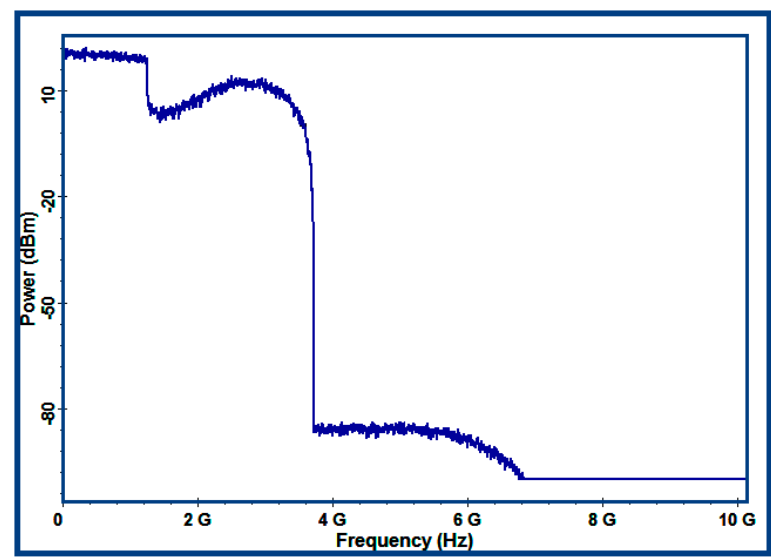
Figure 12. Spectrum of the filtered 4QAM-OFDM signal in the mobile terminal (MT). Electronics 2019 , 8 , x FOR PEER REVIEW